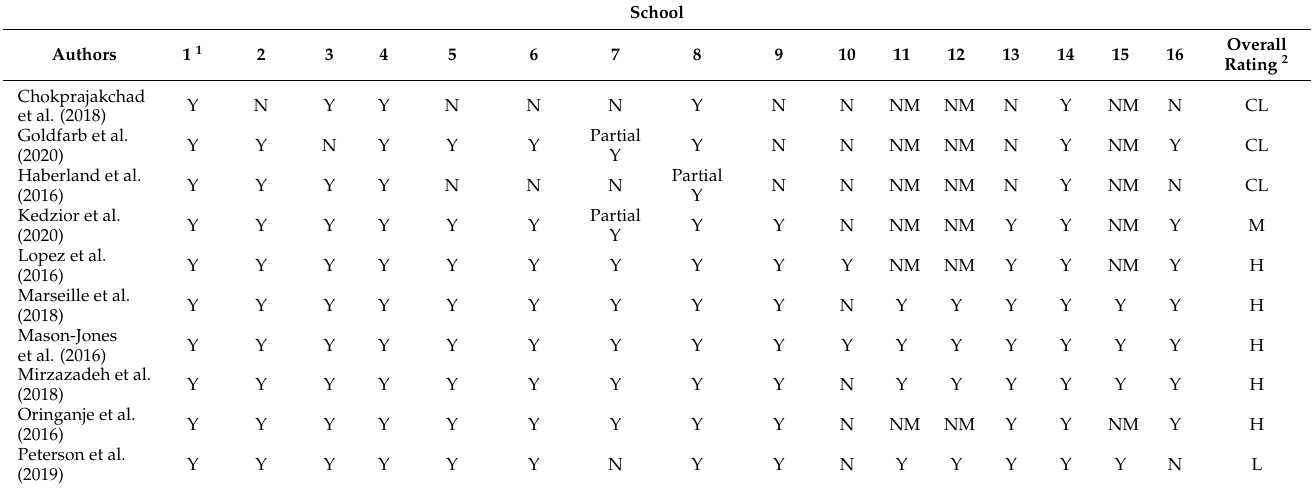
Table A4. Evaluation of the studies included (AMSTAR